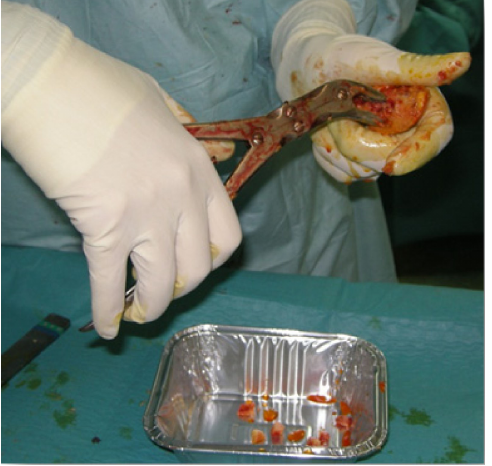
Figure 2. Preparation of morselized bone from an allogenic femoral